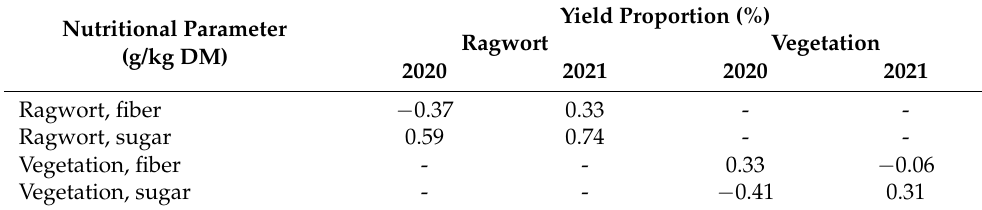
Yield Proportion (%) Ragwort